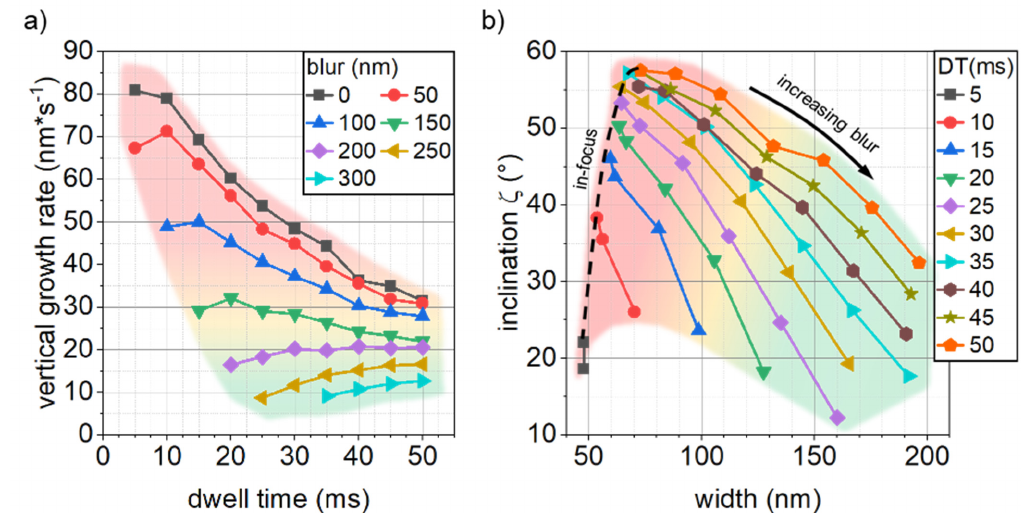
Figure 4. ( a ) vertical growth rate vs. DT for different beam blurs. The graph illustrates the working regime shift from molecule limited regime (MLR) (in-focus, blur < 200 nm, shaded red) towards more electron limited regime (ELR) (blur > = 200 nm, shaded green) conditions for increasing blur values. ( b ) demonstrates the enhanced tunability. While the dashed line illustrates one-dimensional, intrinsic width/inclination behavior, the introduction of a beam blur significantly expands the addressable width/inclination range. The color shading follows the code in ( a ), where green indicates the most balanced range for highest stability and efficiency.